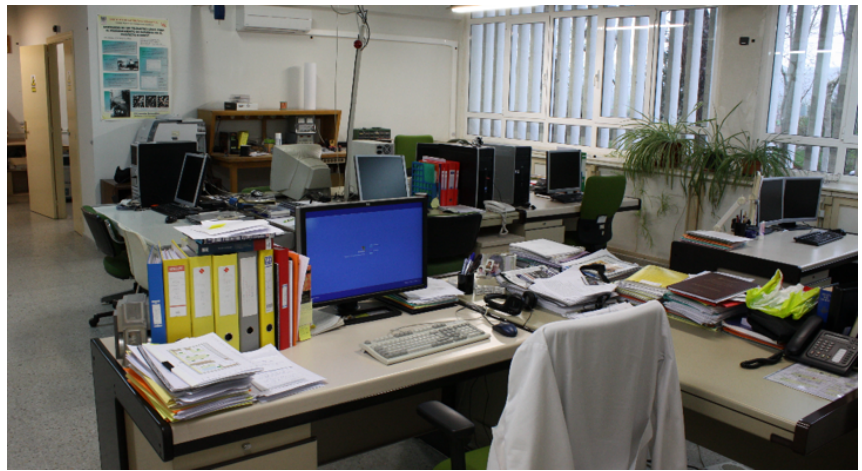
Figure 9. Test environment photo. Laboratory with dimensions of 11.5 m × 6.5 m. It includes a separate room with metallic